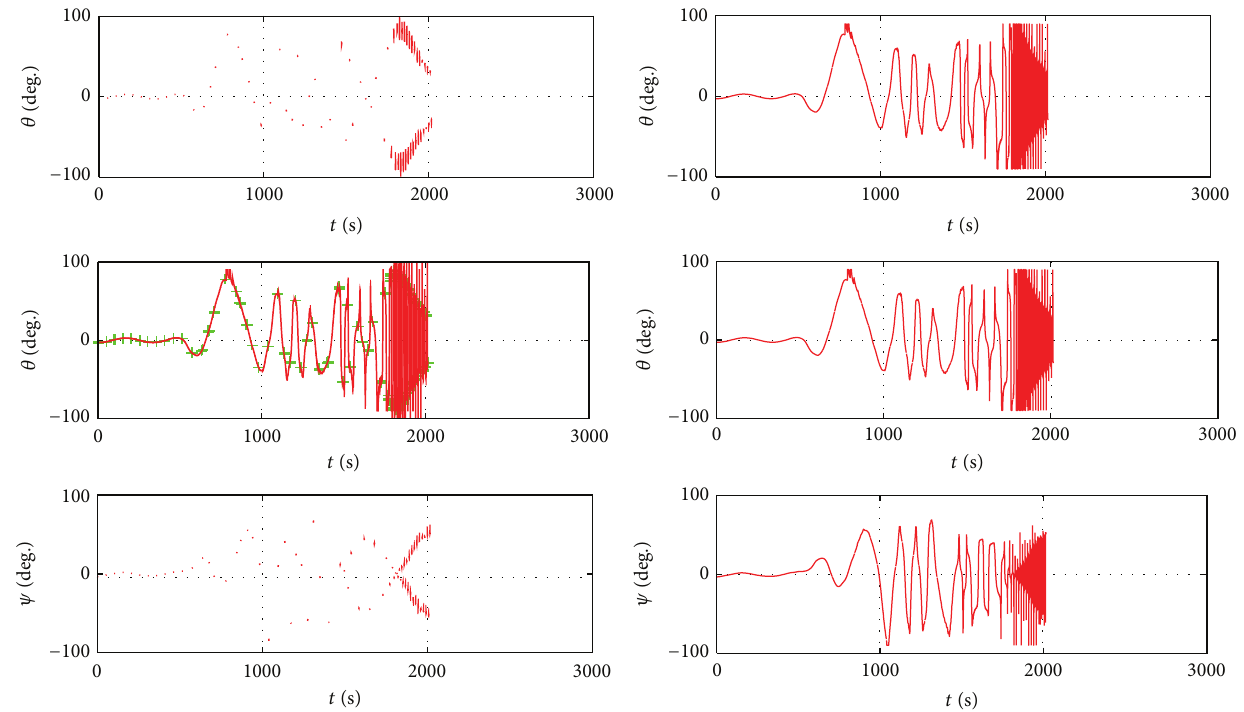
Figure 18: The equivalent expression of in-plane ( 𝜃 ) and out-plane ( 𝜓 ) librations.